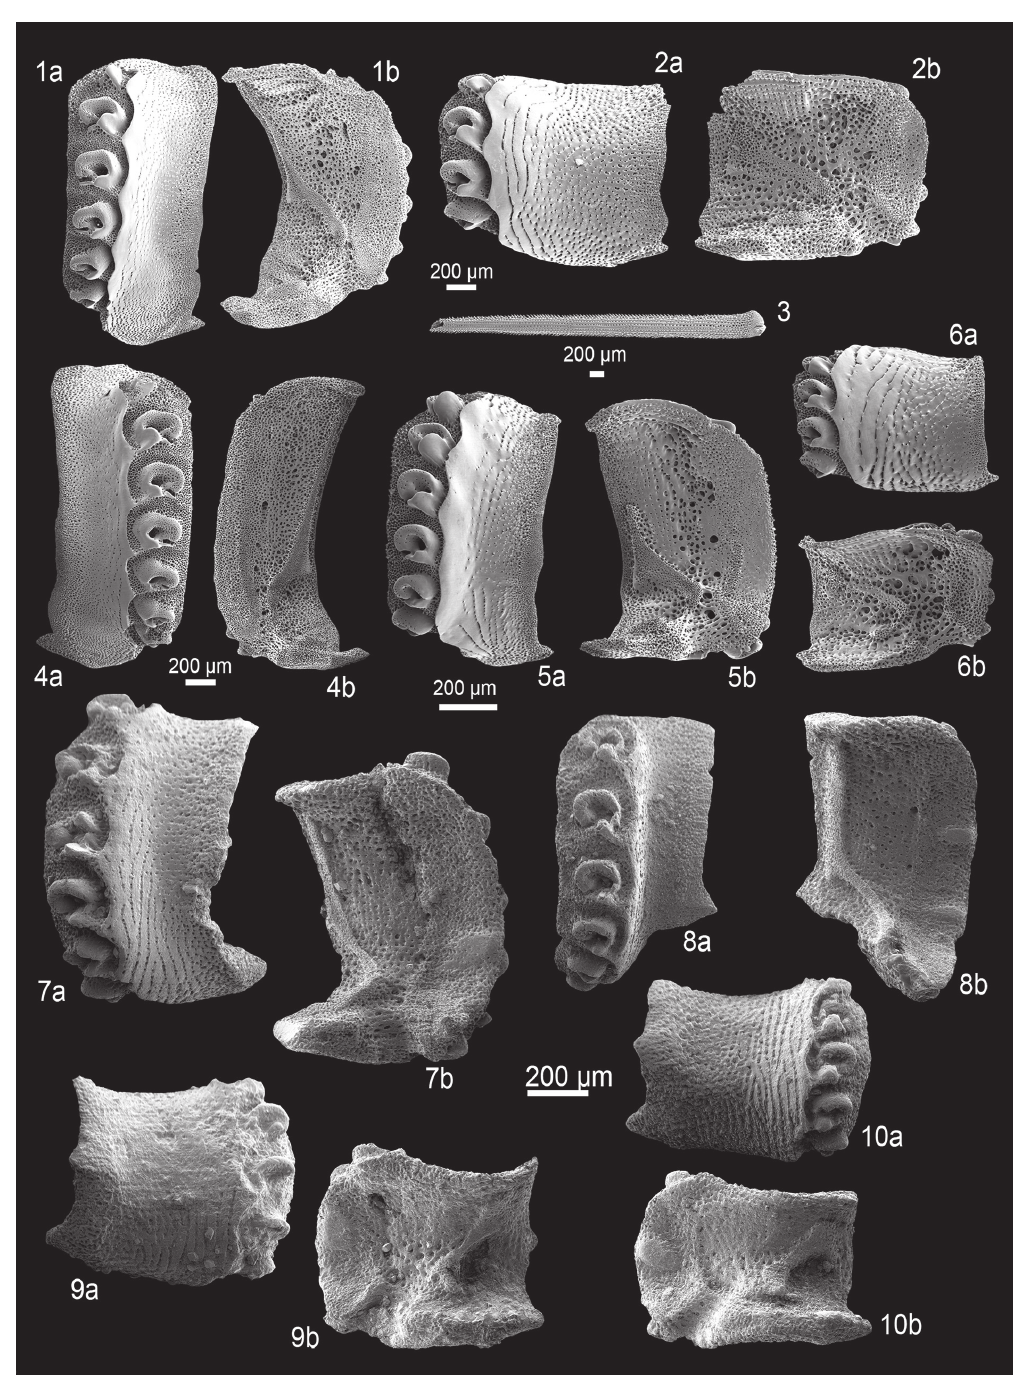
Fig. 16. Skeletal plates of fossil and Recent ophiacanthid brittle stars; lateral arm plates (LAPs) in external (a) and internal (b) views. 1-3. Ophiotreta durbanensis (Mortensen, 1933), Recent. 1. Proximal LAP. 2. Distal LAP. 3. Arm spine. 4. Ophiotreta valenciennesi (Lyman, 1879), Recent; proximal to median LAP. 5-6. Ophiopristis procera (Koehler, 1904), Recent. 5. Proximal LAP. 6. Distal LAP. 7-10. Ophiotreta stefaniae sp. nov. from the late Oxfordian (Late Jurassic) of the Plettenberg, Germany. 7. GZG.INV.78583 (holotype), proximal LAP. 8. GZG.INV.78584 (paratype), proximal LAP. 9. GZG. INV.78585 (paratype), median LAP. 10. GZG.INV.78586 (paratype), distal LAP. One common scale bar per species is given, except for